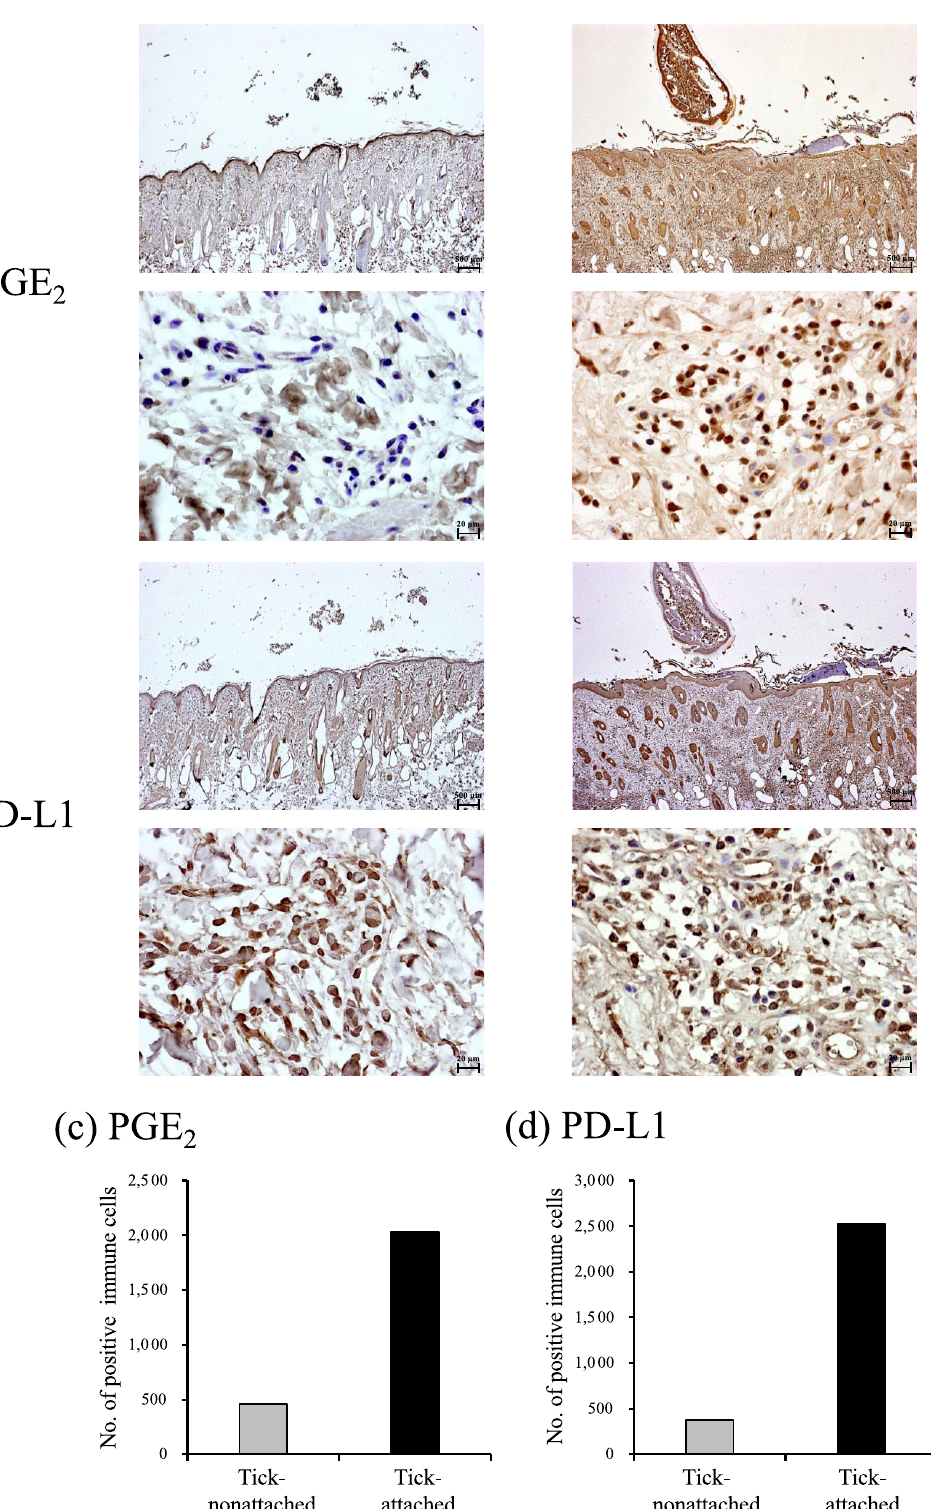
Figure 4. PGE 2 and PD-L1 expression in R . microplus -attached and nonattached sites. ( a , b ) Immunohistochemical staining of PGE 2 ( a ) and PD-L1 ( b ) in tick-attached and nonattached sites on cattle were performed using anti-human PGE 2 antibody (rabbit polyclonal) and anti-bovine PD-L1 mAb (6C11-3A11). ( c , d ) The number of PGE 2 ( c ) and PD-L1 ( d ) positive immune cells in the sample